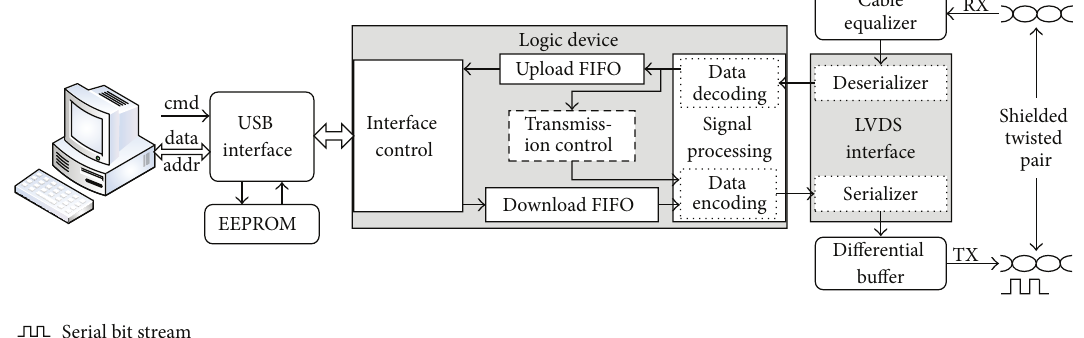
Figure 2: The master node circuit.